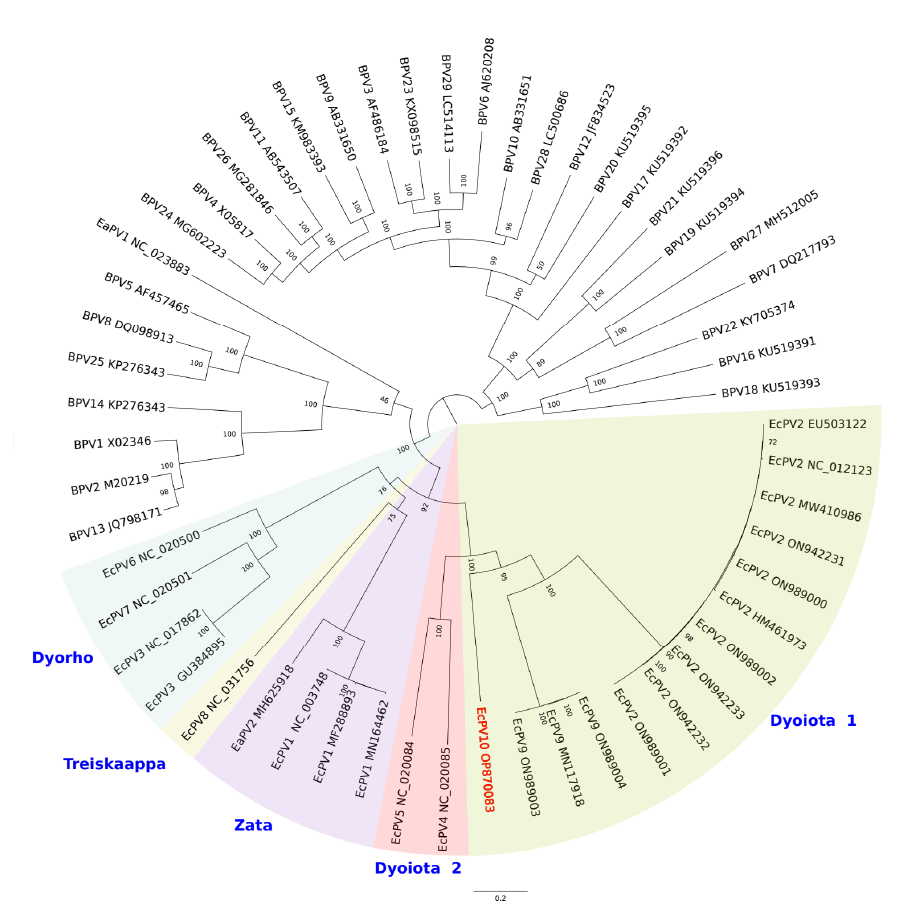
Figure 2. Maximum Likelihood phylogenetic tree based on the concatenated sequences of E1, E2, L2, and L1 genes. Phylogeny was inferred using RaxM. Boostrap values are indicated as node labels. Background colors separate the different EcPV phylogenetic groups from bovine EcPVs, according to [5]. EcPV groups Dyoiota 1 and 2, Dyorho, Treiskaappa, and Zata are indicated in the figure. Our EcPV10 isolate is indicated in red. Table 2. Percentage of sequence similarity based on amino acid sequences of six ORFs